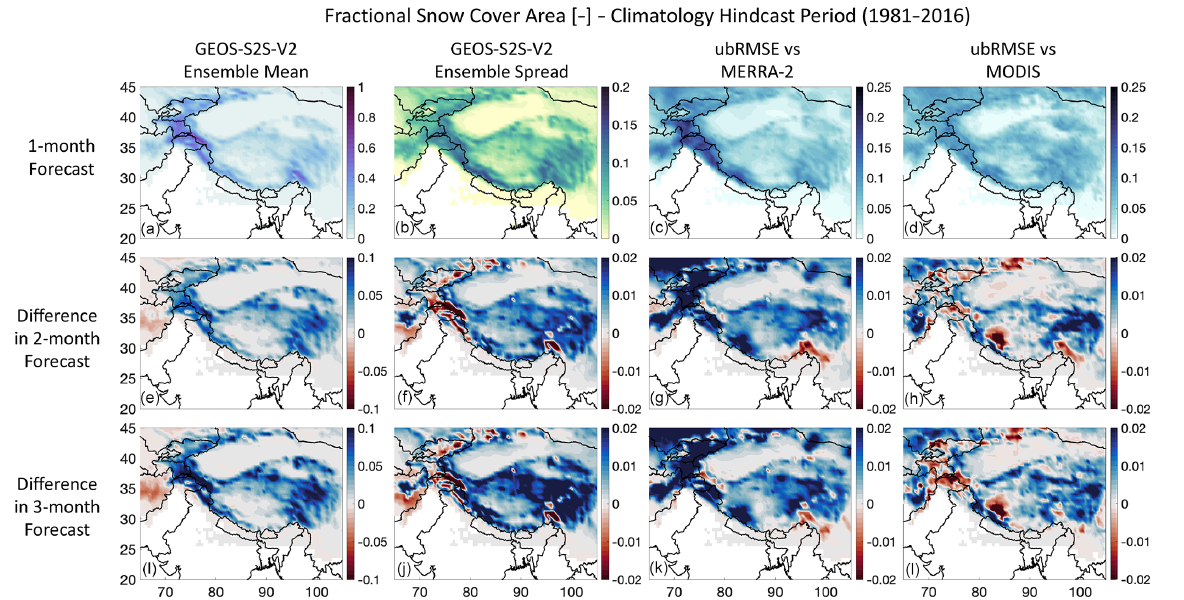
Figure 9. As in Fig. 7, but for fractional snow cover area (fSCA) (unitless) and vs. MODIS in the right column. Grid cells that are masked out (in white) show areas with no-data values. Here, red in the subfigures indicates lower values (i.e., less snow cover, smaller spread, or smaller error) in the 2- and 3-month forecasts, and blue indicates higher values compared to the 1-month